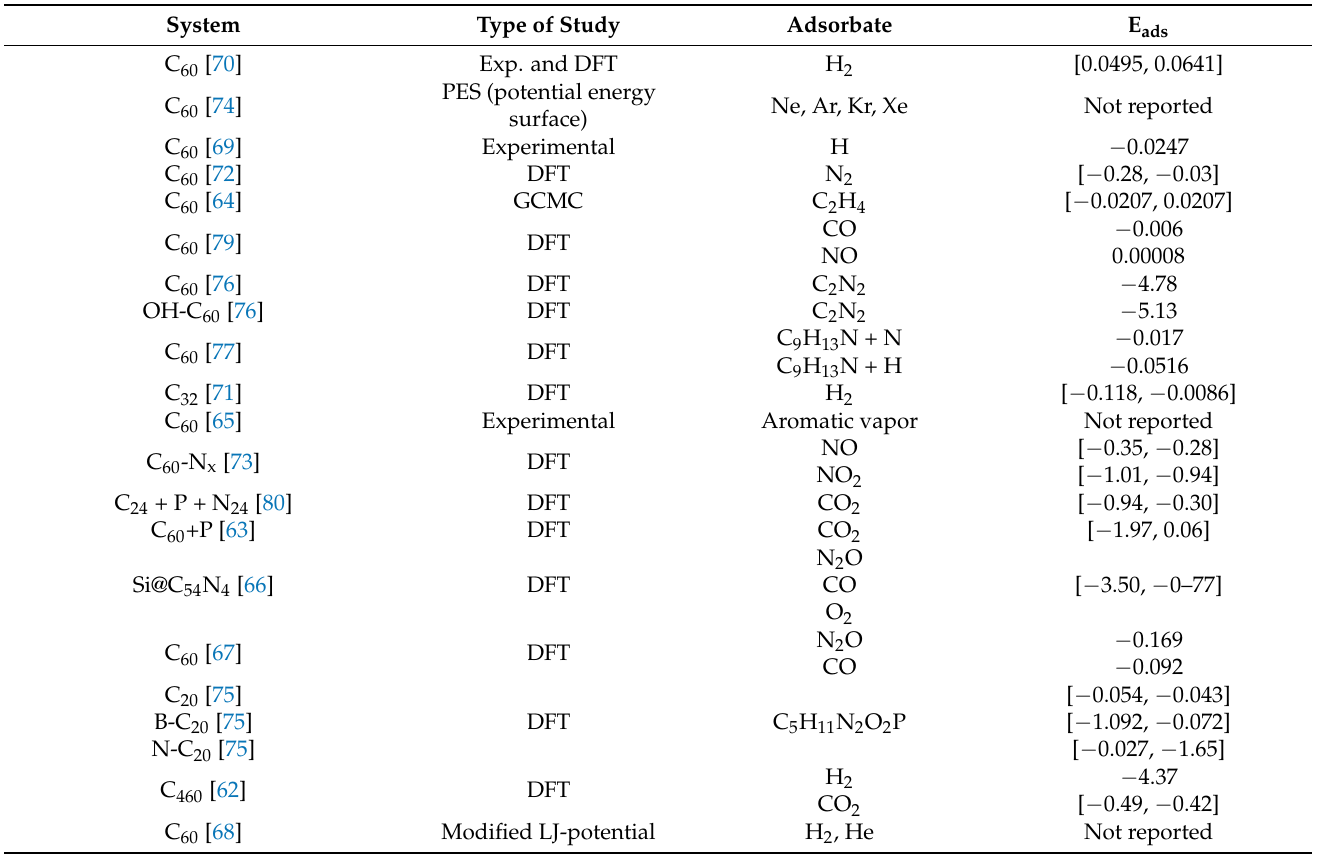
Table 3. Summary of adsorption energies E ads (in eV) for different non-metallic doped fullerene systems and adsorbates. The type of study is also